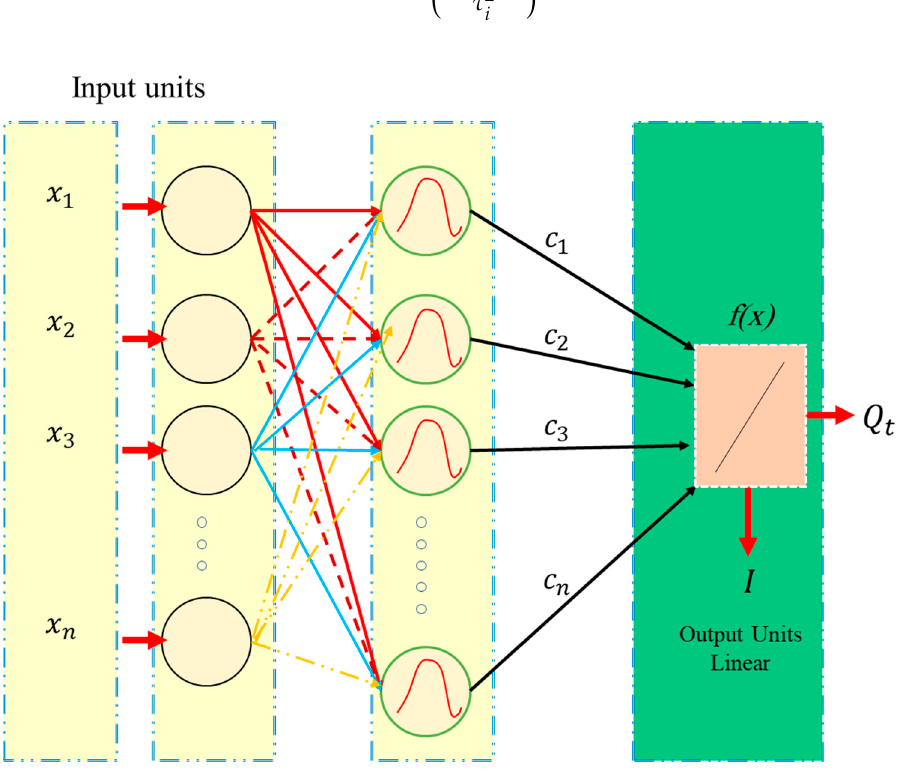
Figure 9. Typical architecture of radial basis function regression (RBFr) neural network.